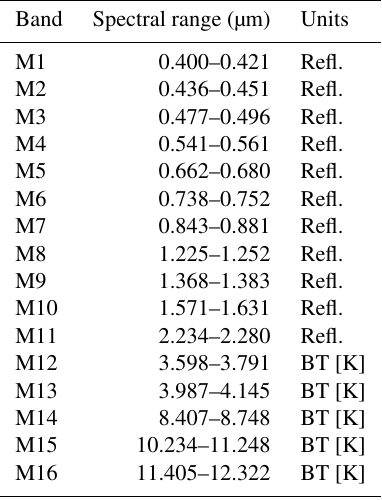
Table 1. The band, spectral range, and units of all 16 moderate- resolution VIIRS channels. Each channel is expressed as a reflec- tivity (Refl.) or a brightness temperature